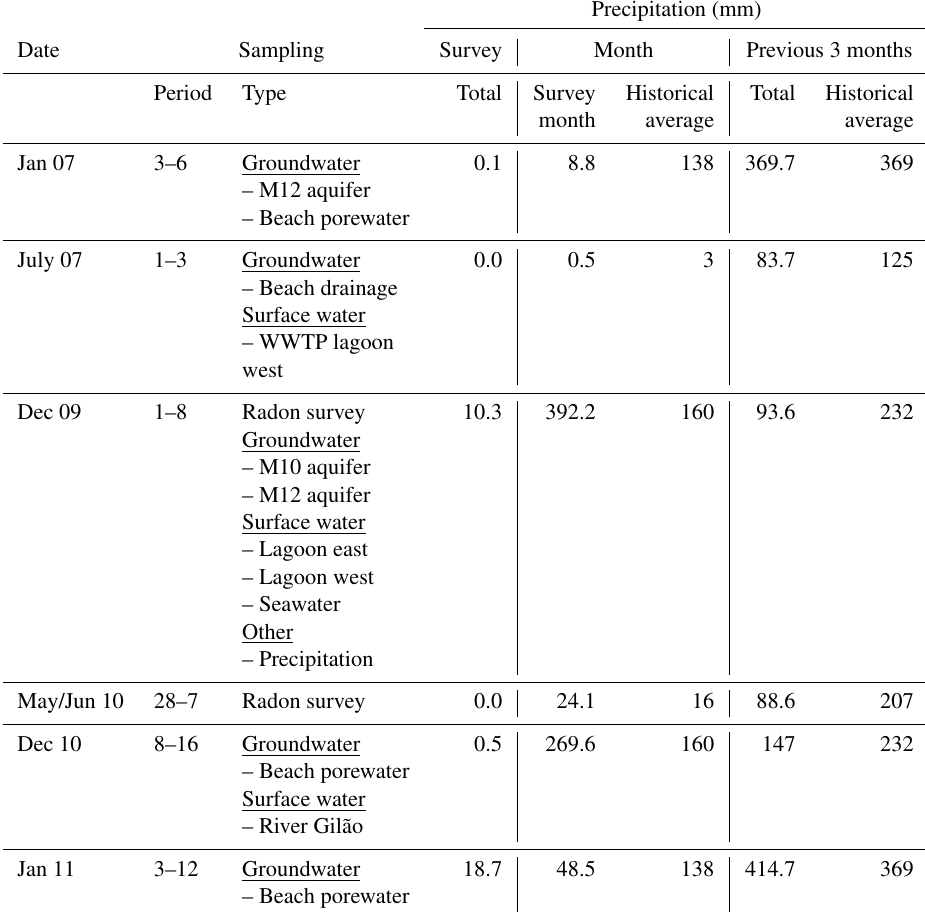
Table 2. Precipitation records over the region during the sampling campaigns described by this study, as measured at the São Brás de Alportel meteorological station (www.snirh.pt, Ref 31J/C). Monthly precipitation is contrasted with rainfall during the sampling campaigns and compared with historical monthly averages in order to evaluate the relative wetness of the periods in the wider temporal context. Accumulated precipitation during the 3 months prior to the month fieldwork took place is also shown and similarly compared to the historical record average. For a more detailed contextual assessment, the chronological record of daily precipitation for the period 2006–2013 is shown in Fig. 4d, with the sampling periods overlain for easy reference when evaluating the stable isotope hydrology of the catchment defined by this study and previous research. Under “Sampling”, and “Type”, the type of end-member collected for stable isotope analysis is shown, except when radon survey campaigns were executed in parallel – in this case “Radon survey” is added to the column. More details on the individual samples are shown in Table